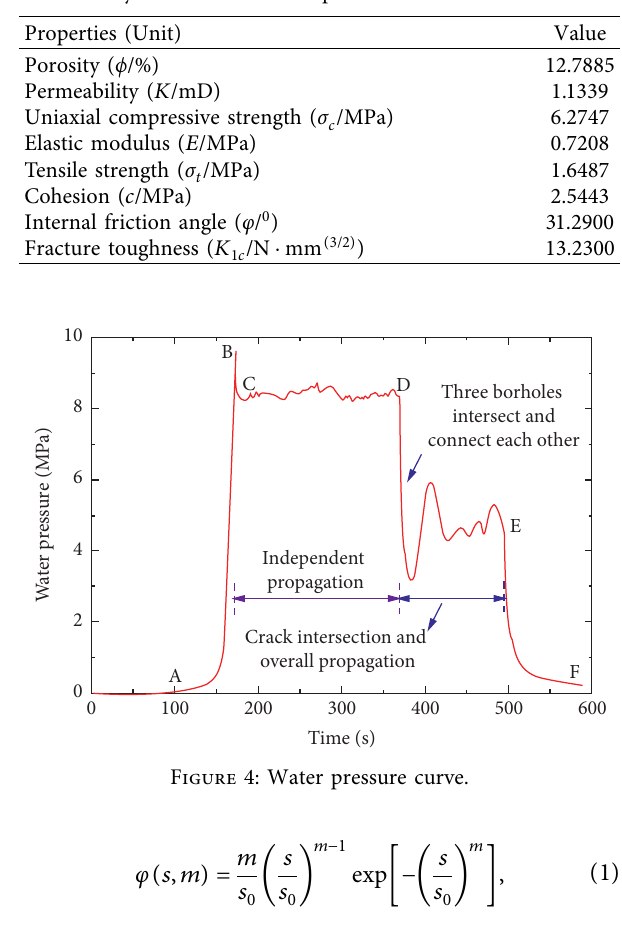
Table 1: Physical and mechanical parameters of the cement mortar.